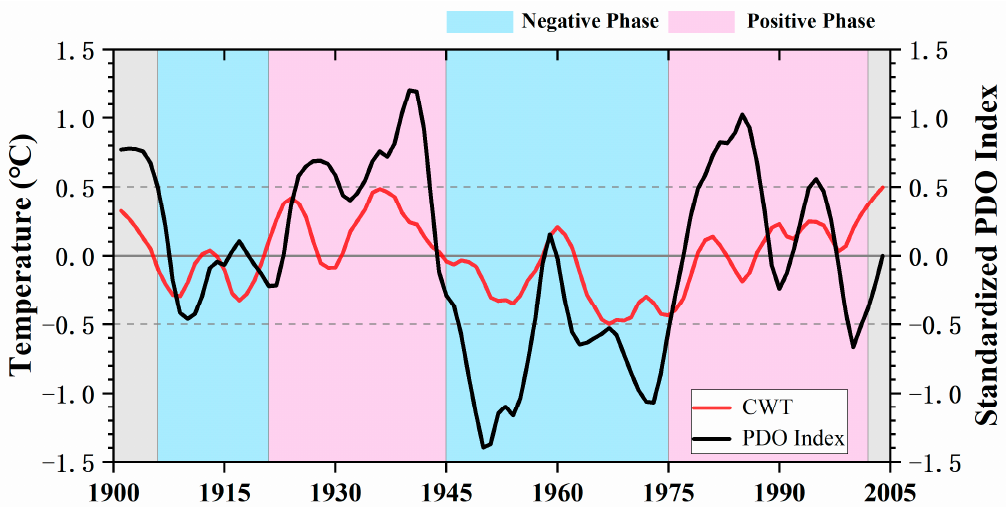
Figure 8. Six-year moving average annual normalized PDO index and CWT. The pink and blue shading represent the positive and negative phases of the PDO, respectively. Grey shading is not classified due to incomplete stages.